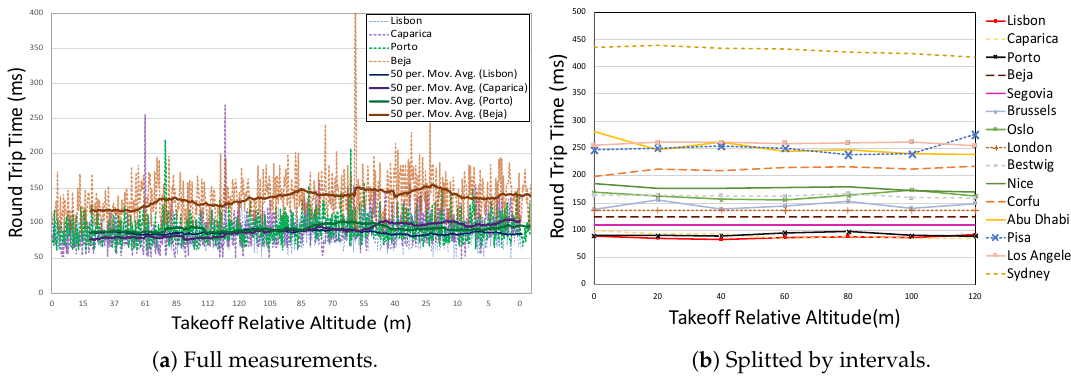
Figure 10. RTT in function of the UAV take off relative altitude. Table 3. Variation of round trip time in function of the UAV relative altitude by intervals, using the Lisbon measurements